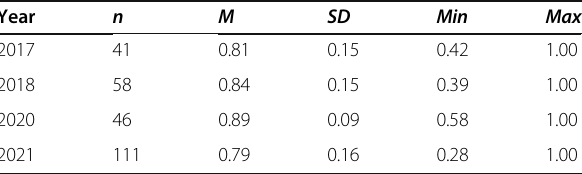
Table 9 Mid Semester Total Evaluation scores ’ descriptive